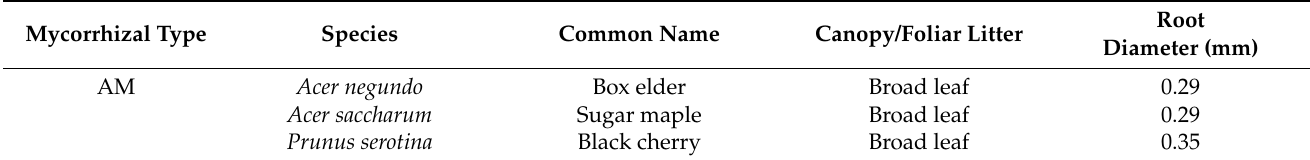
Table 1. Root diameter, mycorrhizal type, and foliar litter trait from 13 temperate trees at a plantation in Pennsylvania,